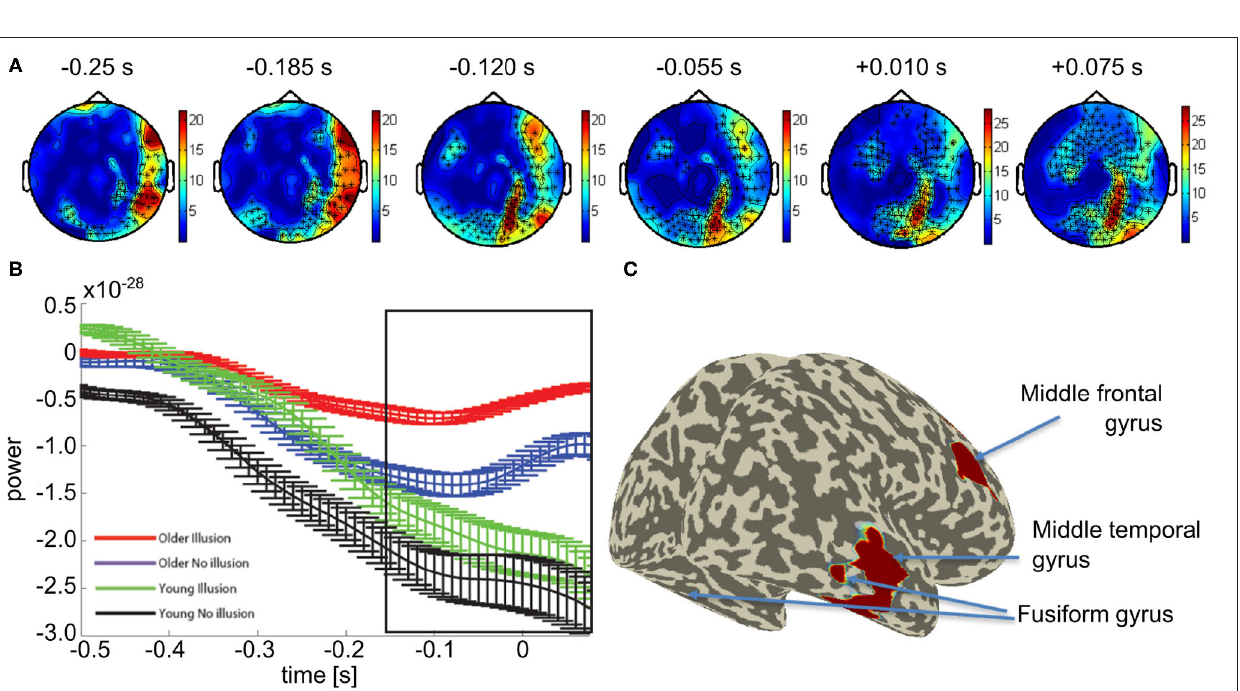
FIGURE 3 | Mean effect of age group in the beta band: (A) Topological plot showing locations of the significant MEG channels (black crosses). (B) Average beta-band power over time for significant channels (means and SEM, see Supplementary Figures 4–7 for non-averaged results). (C) Source localization results of the beamformer analysis of beta band power within the time window indicated by the black box in (B)